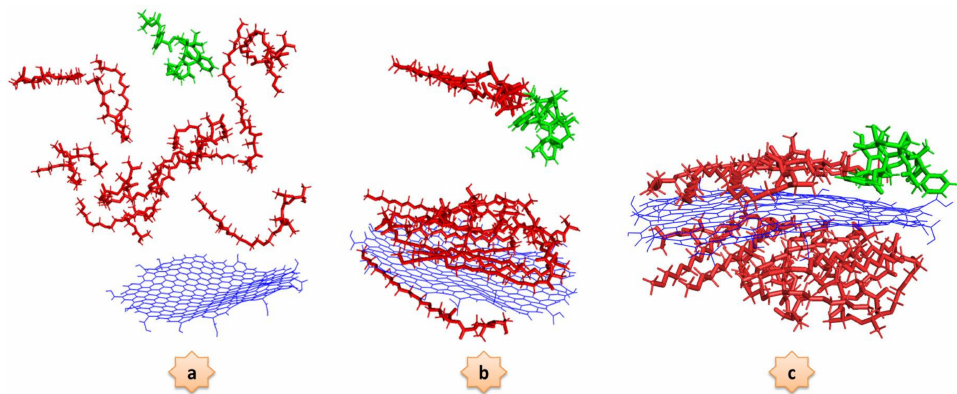
Figure 3. Representative snapshots corresponding to the interaction of docetaxel molecules and graphene quantum dot oxide in the presence of PEG-PLA copolymer at three different times: ( a ) 0 ns, ( b ) 25 ns, and ( c ) 50